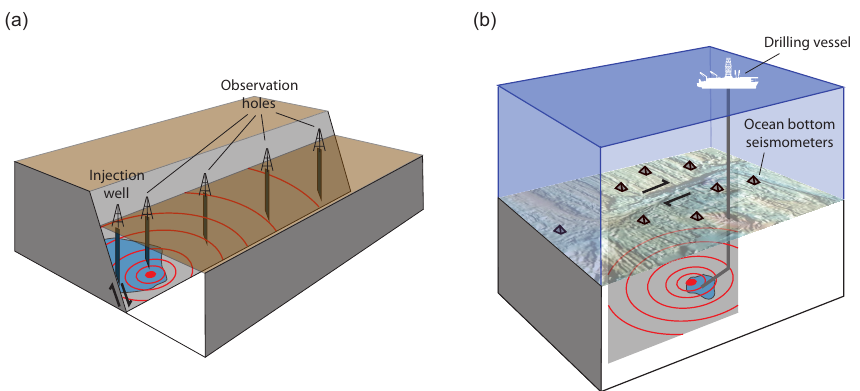
Figure 1. Potential target faults. (a) Continental fault observatory. Fluids pumped at the injection well will trigger an earthquake that can be recorded with seismometers, temperature sensors, strain meters, etc., at the observation holes. (b) Oceanic transform fault observatory. Fluid injected from a ship would trigger an earthquake on the fault that would be recorded by a network of ocean bottom seismometers (OBS in grey pyramids). Observation holes may also be drilled in advance of the